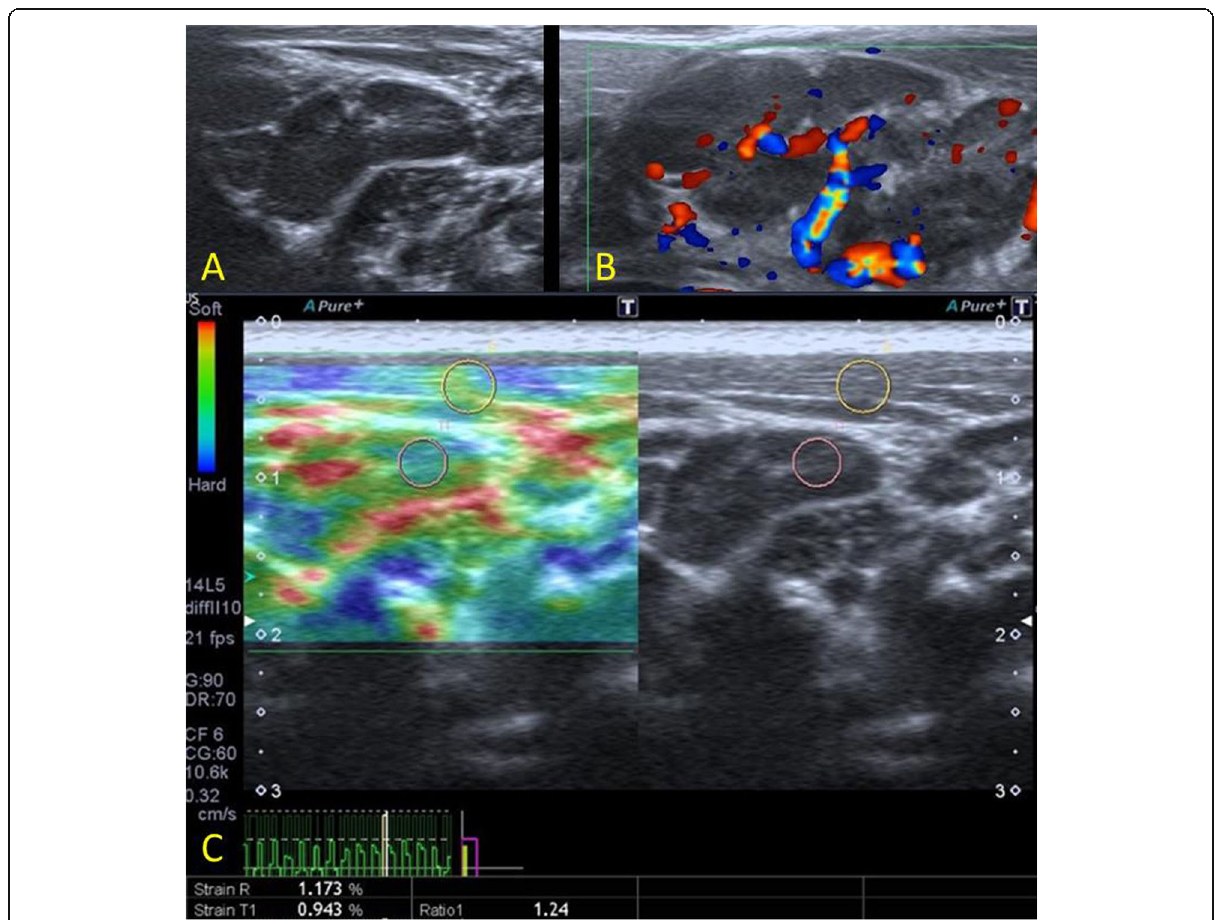
Fig. 2 B-mode US ( a ) revealed a well-defined, hypoechoic, oval right upper deep cervical lymph node with preserved hilum, L/S ratio was 2.54. Color Doppler ( b ) revealed central hilar internal vascularity. The split-screen US elastogram ( c ) of the same lymph node revealed type 1 color pattern, strain ratio value was 1.17. Histopathological evaluation revealed non-specific